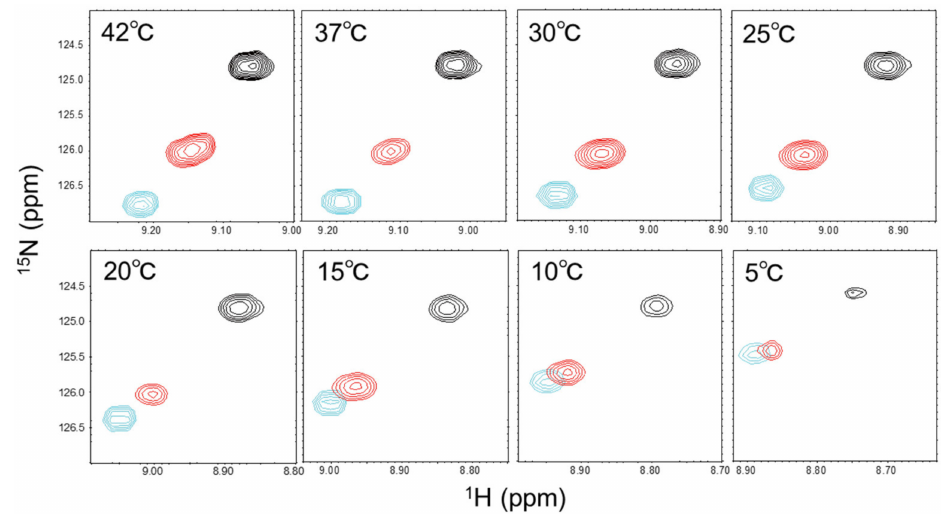
Figure 1. Temperature-dependent 1 H- 15 N HSQC spectral change of diUb. 1 H- 15 N HSQC peaks originating from Val70 of monoUb (cyan), diUb (red), and c-diUb (black) at the following different temperature conditions: 42 ◦ C, 37 ◦ C, 30 ◦ C, 25 ◦ C, 20 ◦ C, 15 ◦ C, 10 ◦ C, and 5 ◦ C.